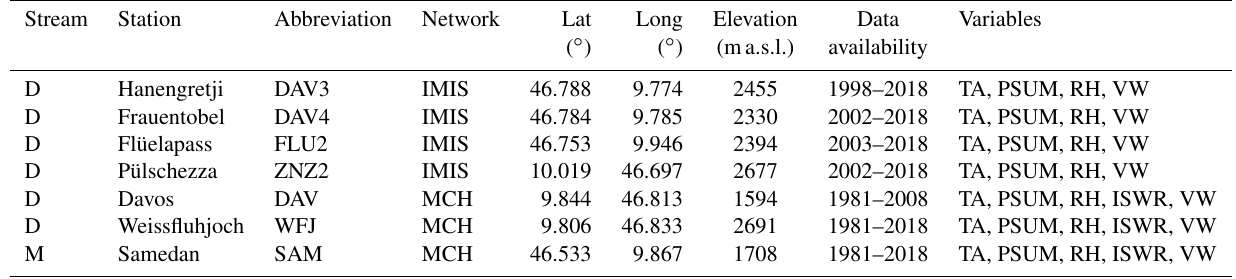
Table 2. Details about Swiss meteorological stations (IMIS and MCH). The first column of the table indicates the associated river (D and M for Dischma and Mera, respectively). In contrast to ARPA in Table 3, all variables started to be recorded automatically in the same year: 1981.